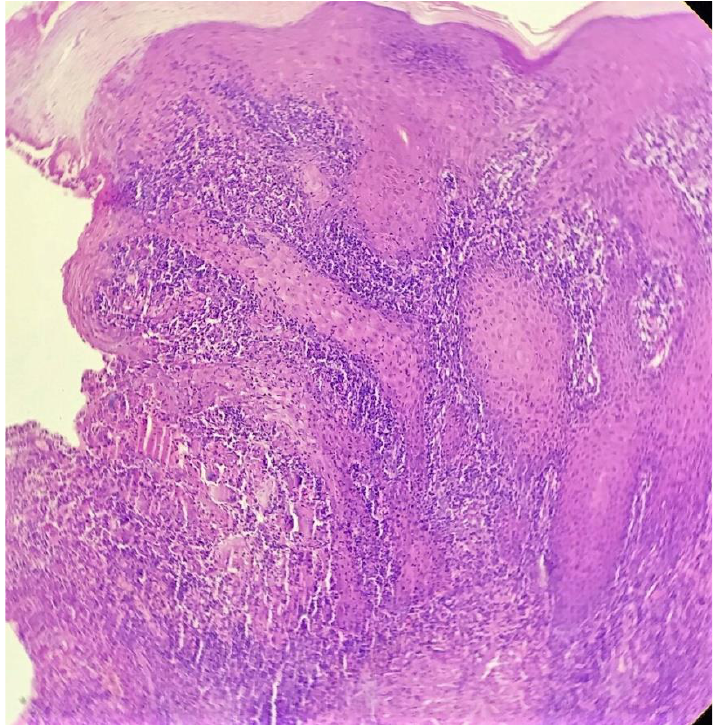
Figure 2. Lichenoid granulomatous dermatitis pattern with psoriasiform epidermal hyperplasia (H&E × 40).